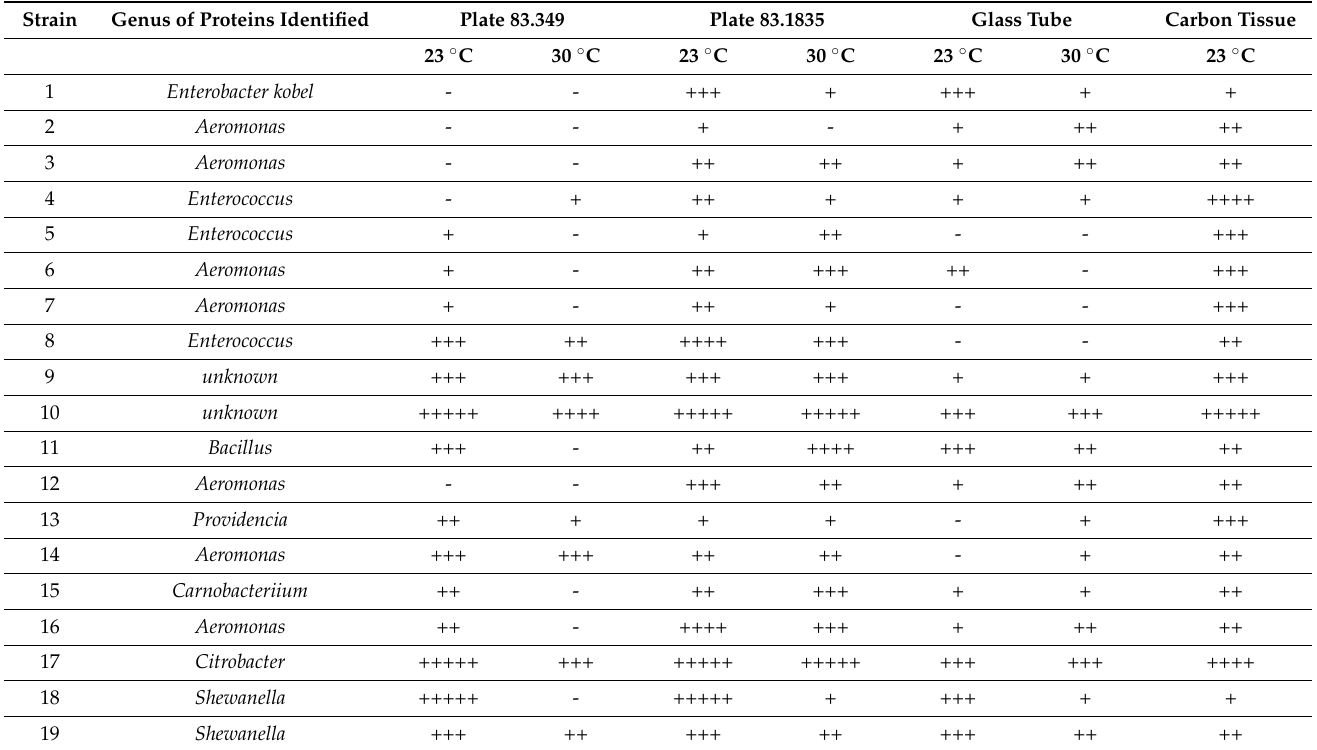
Table 2. Biofilm-forming capacities of the mud-isolated bacteria, tested on adhesive- and nonadhesive polystyrene 96-well plates, glass surfaces, and carbon tissue (PXFT-35). Biomass was ranked on 5-point scale. In case of the 96-well plates the intensities of the solubilised stains, while in case of the glass surfaces, the biofilm ring was ranked. Biofilm-forming capacities of the isolates on the carbon tissue were ranked on a 5-point scale. (+: single and slightly diffuse bacteria can be seen on the surface of the carbon fibres; ++: dense and diffuse bacteria can be seen on the carbon fibres; +++: